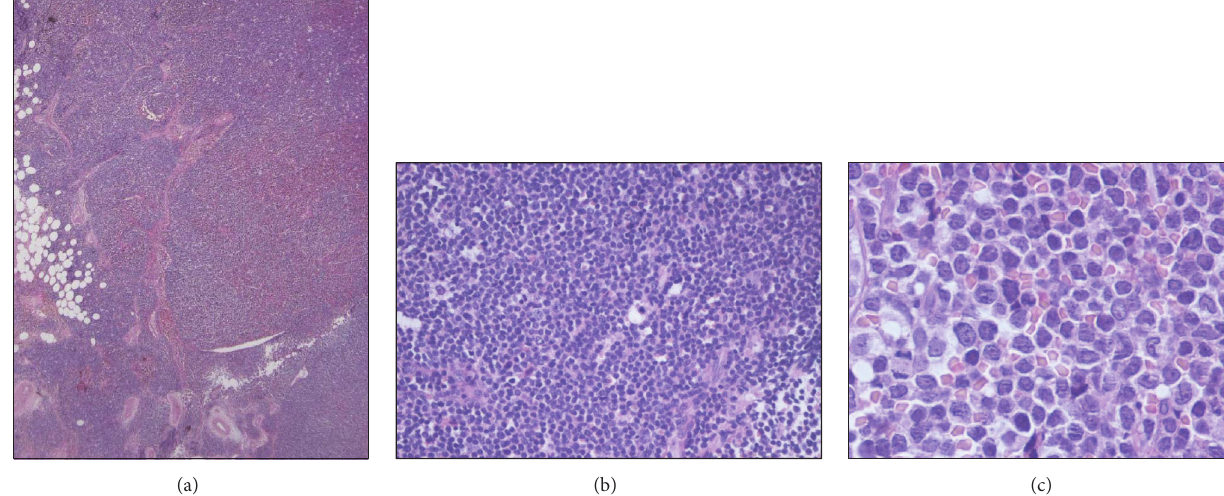
Figure 3: Laterocervical lymph node biopsy: EE20x (a), EE100x (b), and EE400x (c) diffuse and partially nodular infiltration by blast cells with complete effacement of lymph node architecture.